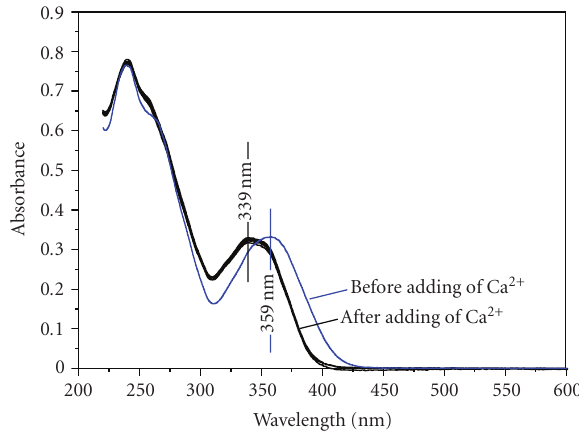
Figure 2: Changes in the absorption spectra of 4d solution after adding of calcium ions.